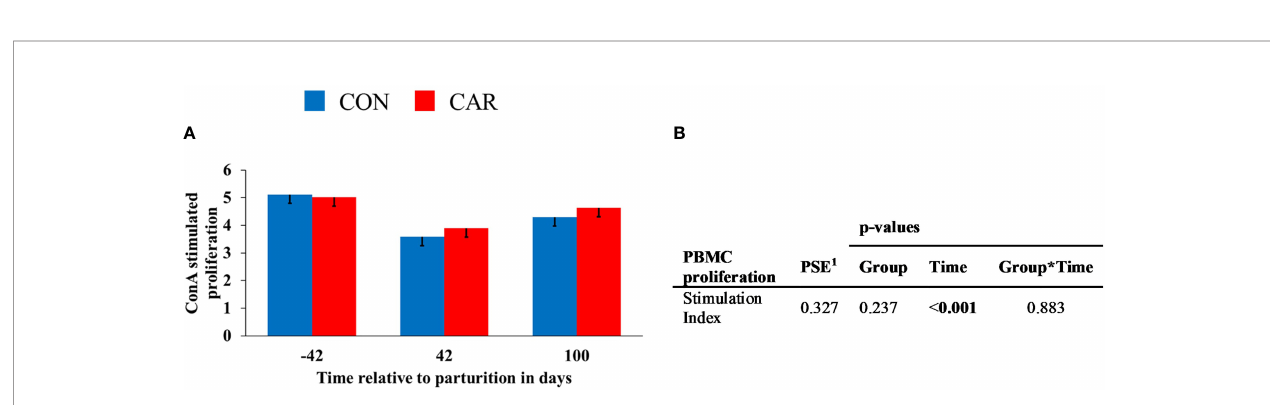
FIGURE 7 | Flow cytometric quanti fi cation of monocyte population in dairy cows fed a diet supplemented with (CAR) or without (CON) L-carnitine from 6 weeks before until 15 weeks after parturition. (A) percentage of cells expressing monocytes (CD14 + ) and (B) mean fl uorescence intensity (MFI) of monocytes (CD14 + ). (C) Data statistics. Data are shown as least square means. 1 pooled standard